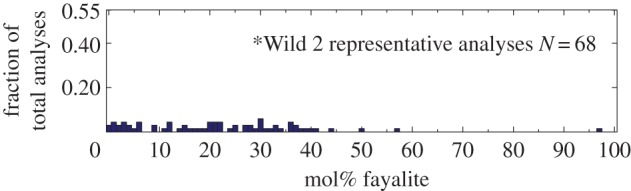
Distributions of fayalite content (mol%) for olivine in (Stardust) Wild 2 terminal particles and chondrite matrix. *Includes analyses from 36 particles harvested from 26 tracks; data was obtained by us [12] and [15,100,165,166,178,189,203,279–281] (reproduced with permission from [12], fig. 1. Copyright © 2014 Elsevier). Representative analyses is one analysis per particle, unless individual crystallites within a single particle differ by greater than or equal to 3 mol% fayalite. (Online version in colour.)